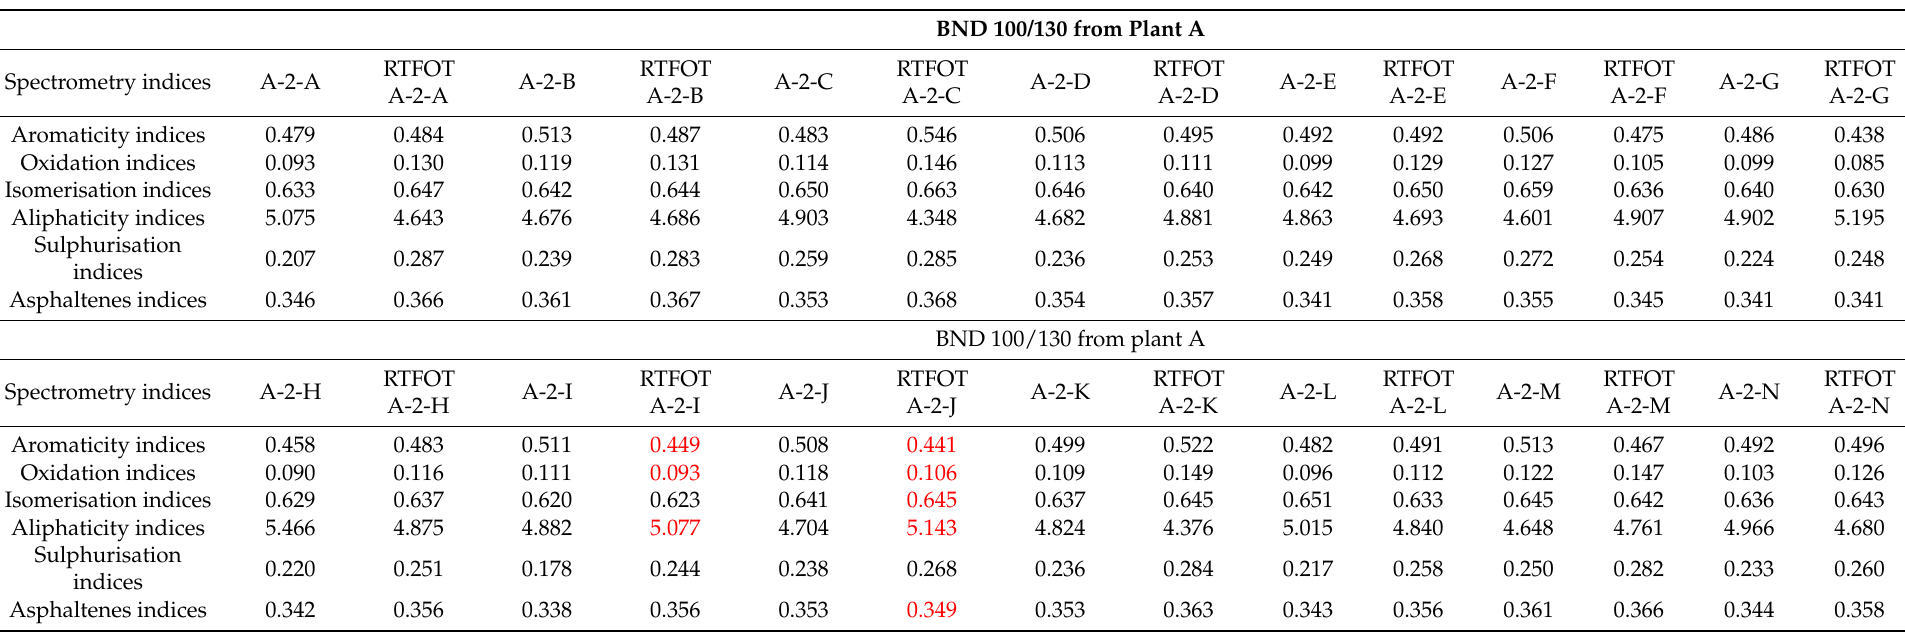
Table 9. Calculation of spectrometry indices of BND 100/130 from plant A before and after